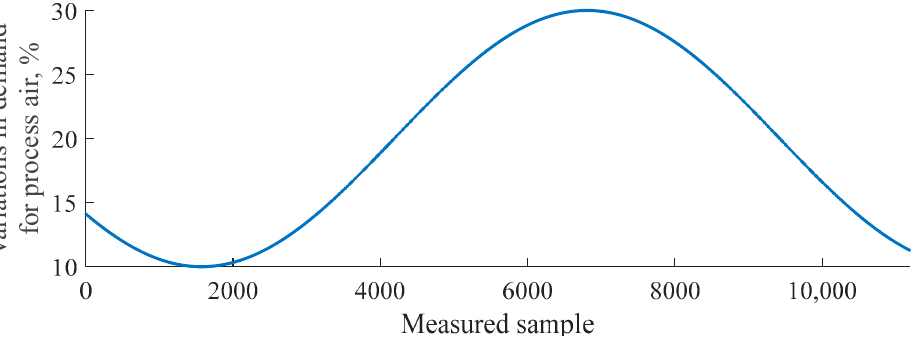
Figure 8. Changes in process air demand that represent natural disturbances in the process. In this case, the variance of the HU signal is considerably larger, even when no attack is currently active, leading to increased changes in the Harris index. Based on historical data, a different threshold value has been selected as 0.1 and the attack is assumed active if the Harris index is lower than 0.1.